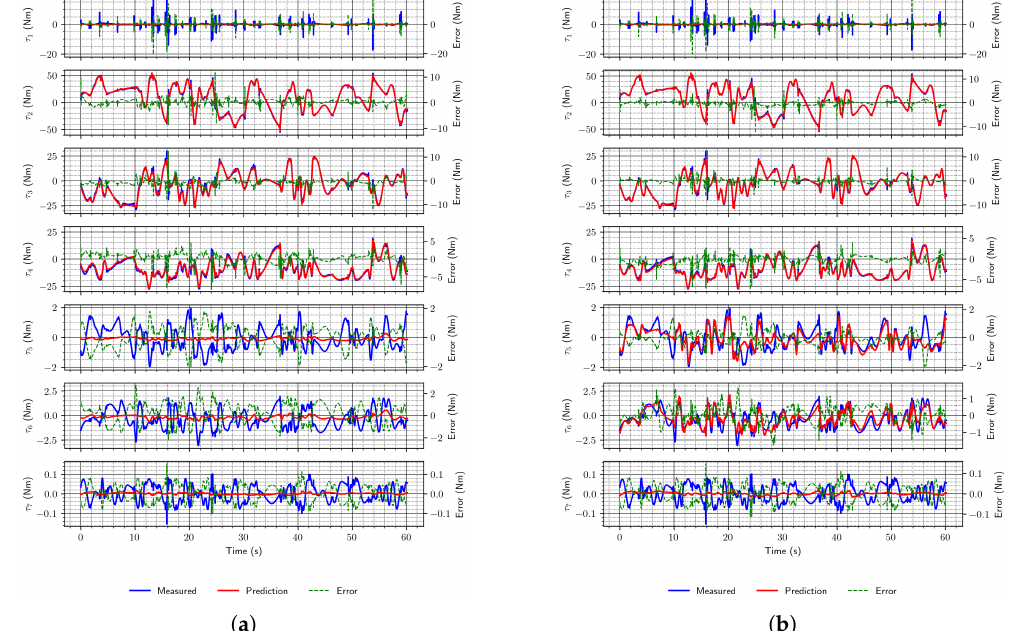
Figure 9. Example torque estimates using convolutional and LSTM network. ( a ) Convolutional network; ( b ) LSTM network.